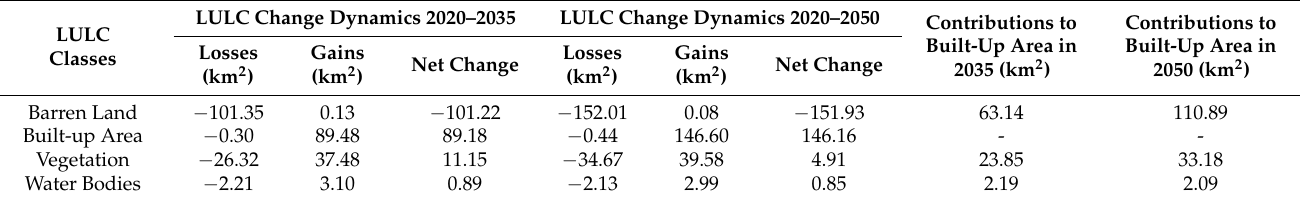
Figure 10. Change dynamics of predicted LULC from, ( a ) 2020 − 2035, and ( b ) 2020 − 2050. Table 7. Predicted change dynamics of LULC in 2035 and